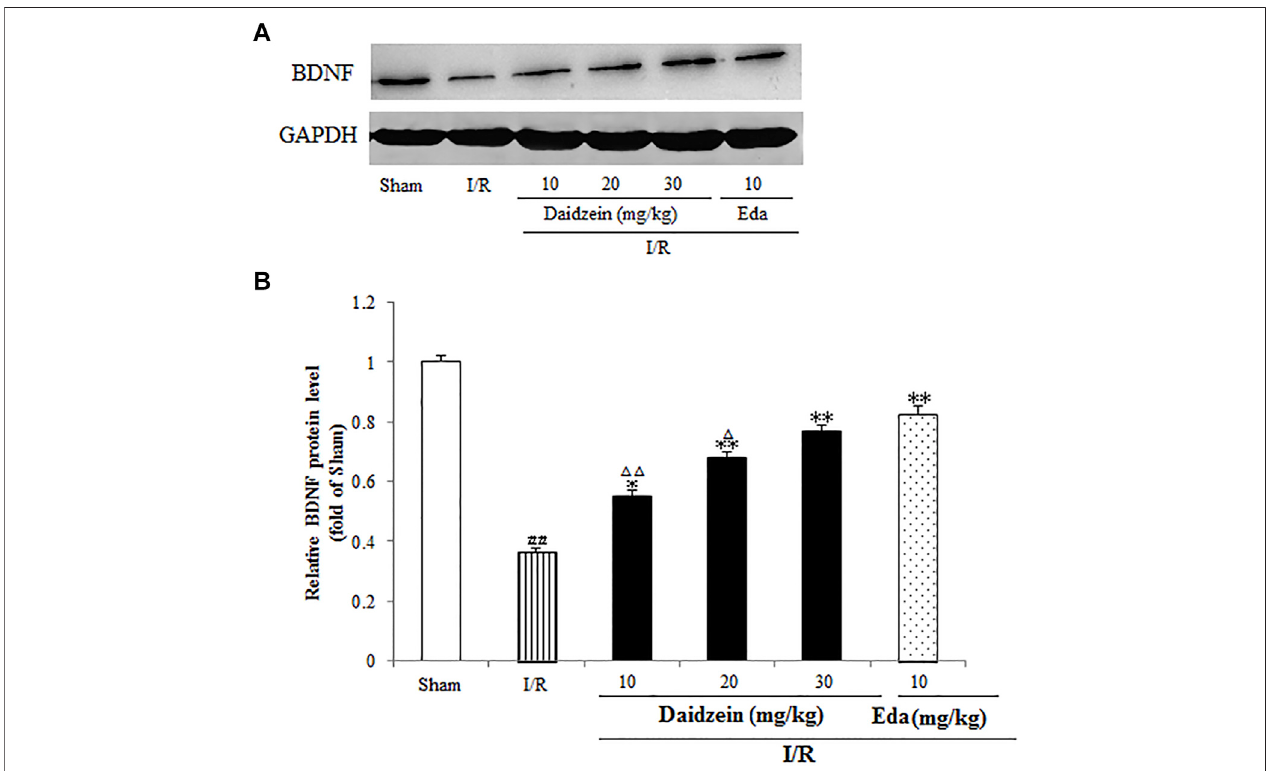
FIGURE 10 | Daidzein conducts the activation for BDNF/Akt/CREB signalling channel for providing neuro-repair in rats. (A) Quantifying process of the relative protein extent of BDNF. (B) Ratio of BDNF/GAPDH. I/R or daidzein-treatment rats ’ brain infarct region. Values are indicated as means ± standard errors of the means (SEMs; n (cid:2) 3). # p < 0.05, noticeably distinct from sham; * p < 0.05, noticeably distinct from I/R; △ p < 0.05, △△ p < 0.01, compared with the Eda